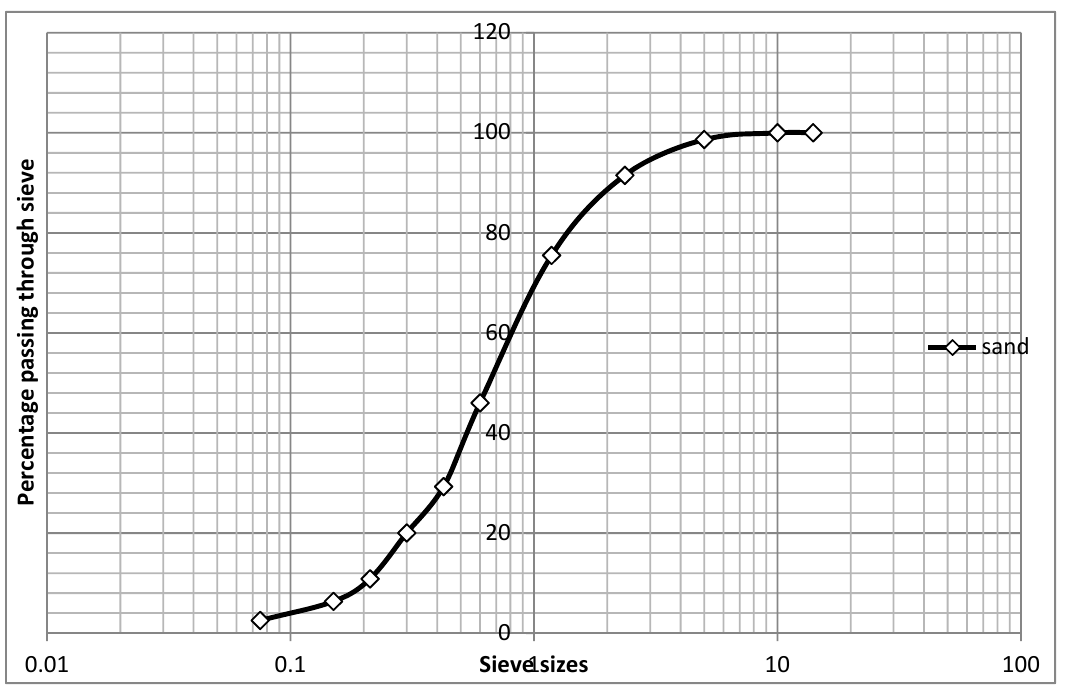
Figure 1. Grading curve for the sand used on a semi-logarithmic plot.